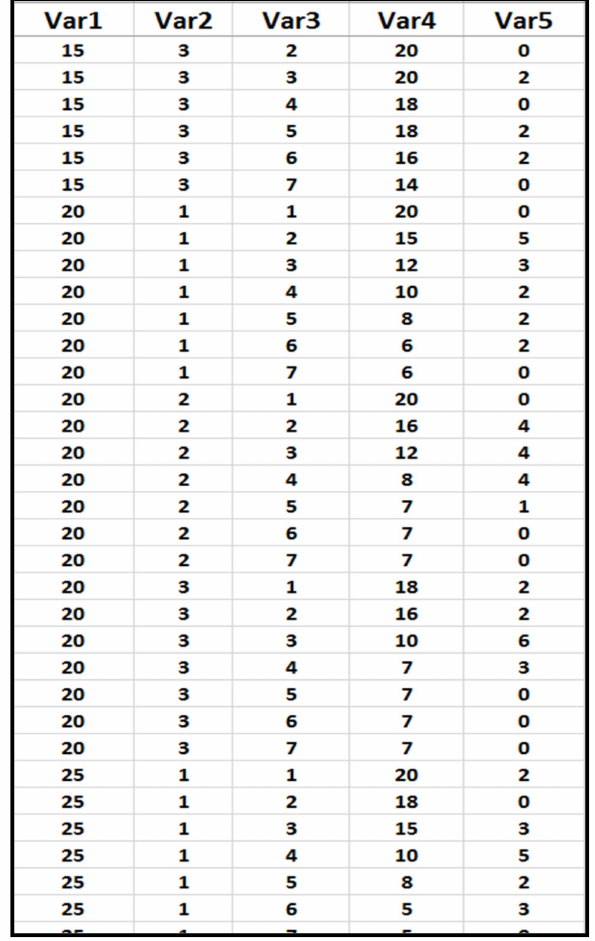
Figure A1. Experimental data: Var1 represents the range of the independent variable (temperature); Var2 is the number of replicates in the experiment, Var3 is the time duration of each experiment; Var4 and Var5 are records of the dependent variable (mortality) with the variation of the independent